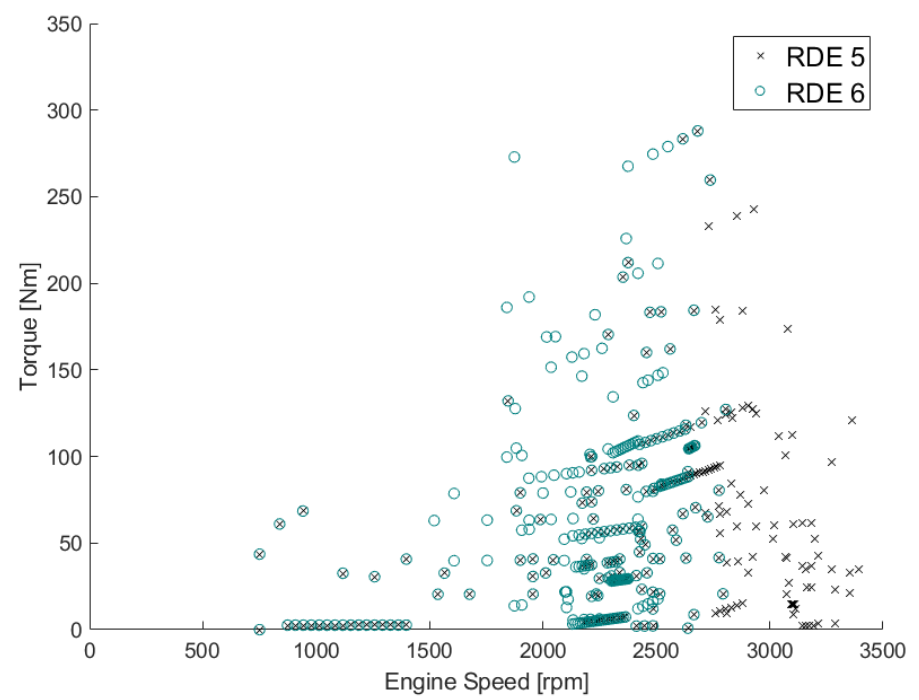
Figure 8. RDE 5 and RDE 6 engine map comparison.